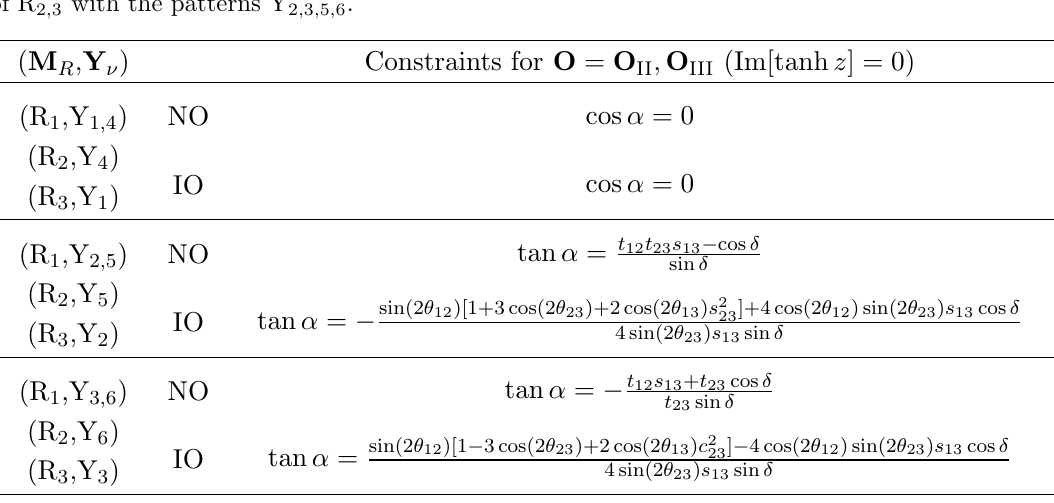
Table 5 . As in table 4, for the cases O = O II ; O III .